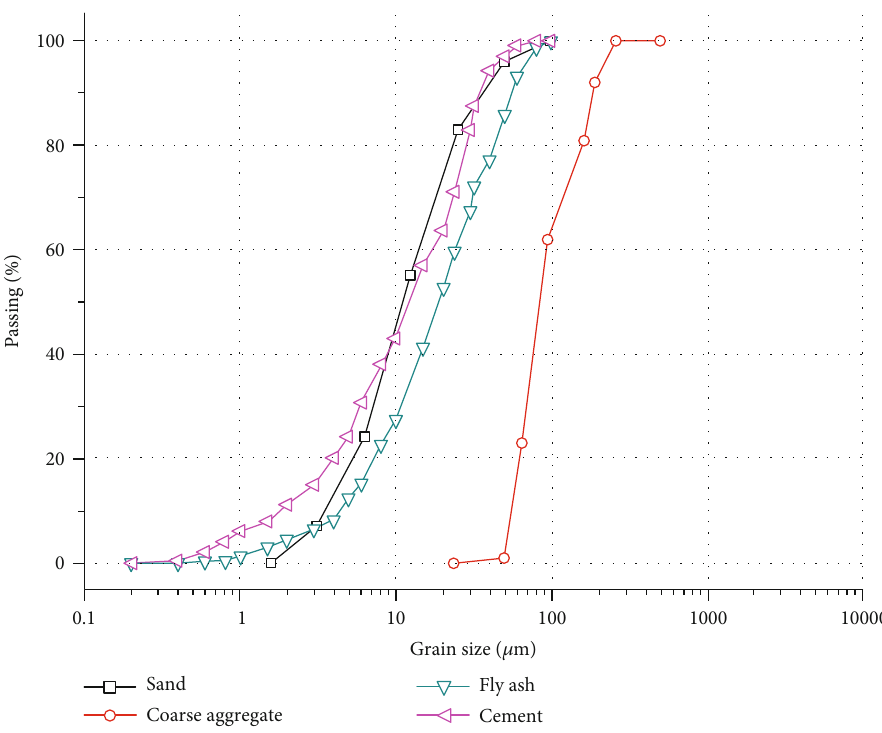
Figure 3: Gradation curves of cement, fl y ash, and fi ne and coarse aggregates. Table 2: Mix proportions of the PC and PPFRC mixtures.